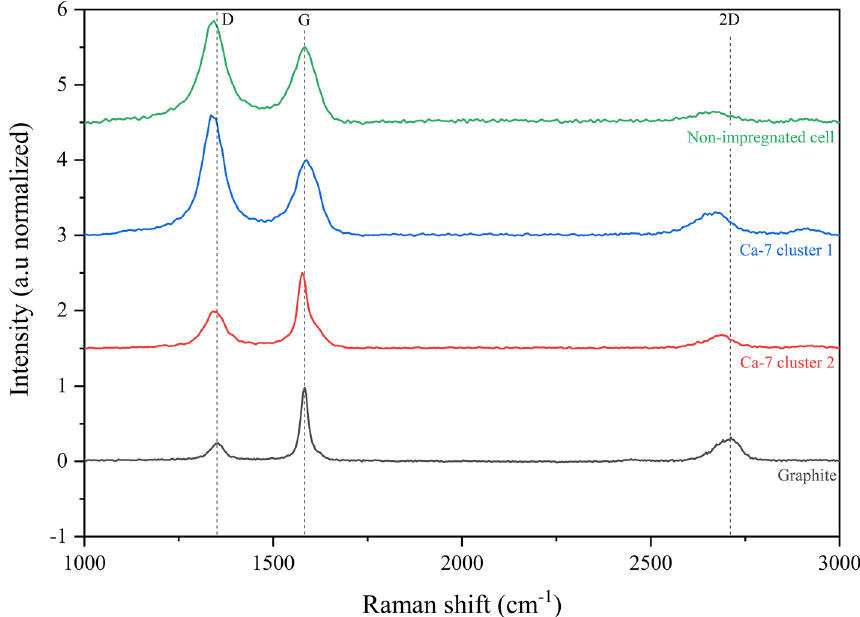
Figure 3. Raman spectra of non-impregnated cell, Ca-7 and commercial graphite